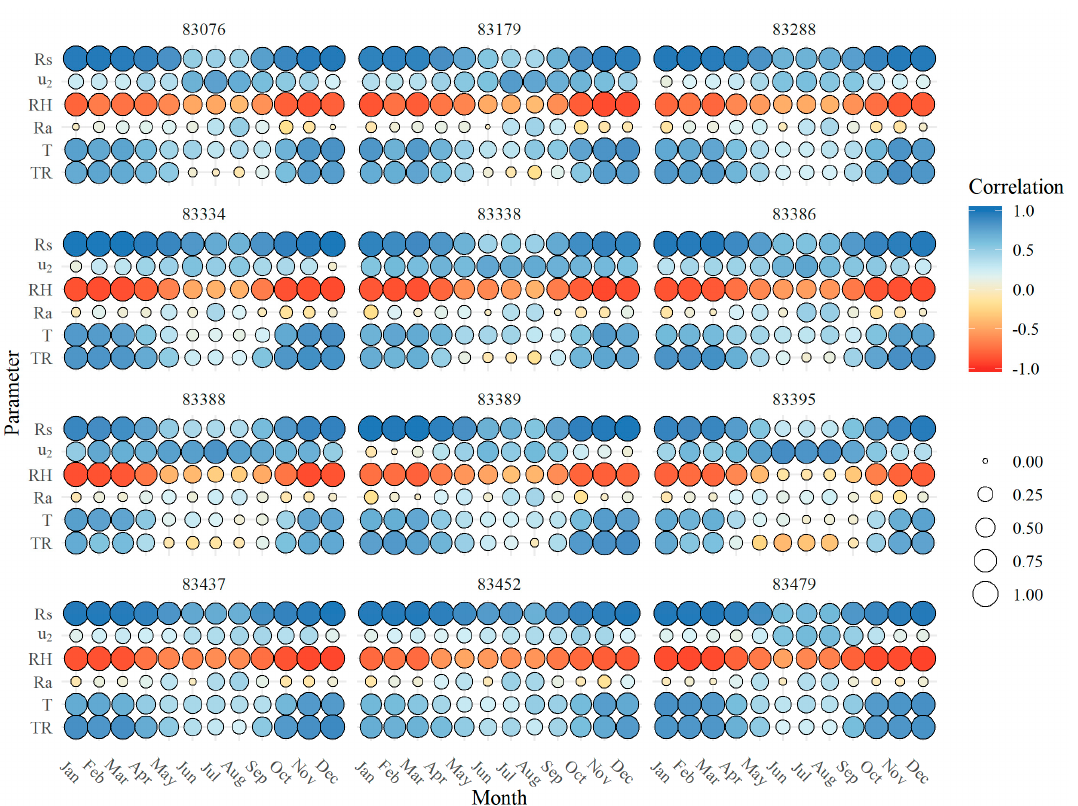
Figure 3. Correlation between Penman–Monteith reference evapotranspiration and meteorological parameters by month and station. Color scale relates to correlation coefficient values, while size scale relates to absolute values of the correlation coefficient.